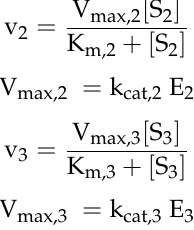
Figure 5. Scheme of phenol oxidation with tyrosinase to produce o-quinone. Studies have shown that the hydroxylation step (monophenolase activity) is much slower than the oxidation step (catecholase activity), and therefore limits the o-quinone production rate [36]. Therefore, we assumed that the rate ( v 2 ) of o-quinone (S 4 ) production from phenol (S 2 ) can be obtained from Equations (11)–(12), where E 2 corresponds to phenolase activity of tyrosinase. The rate ( v 3 ) of conversion of catechol (S 3 ) to o-quinone (S 4 ) can be given by Equations (12) and (13), where E 3 denotes the catecholase activity of tyrosinase [29]